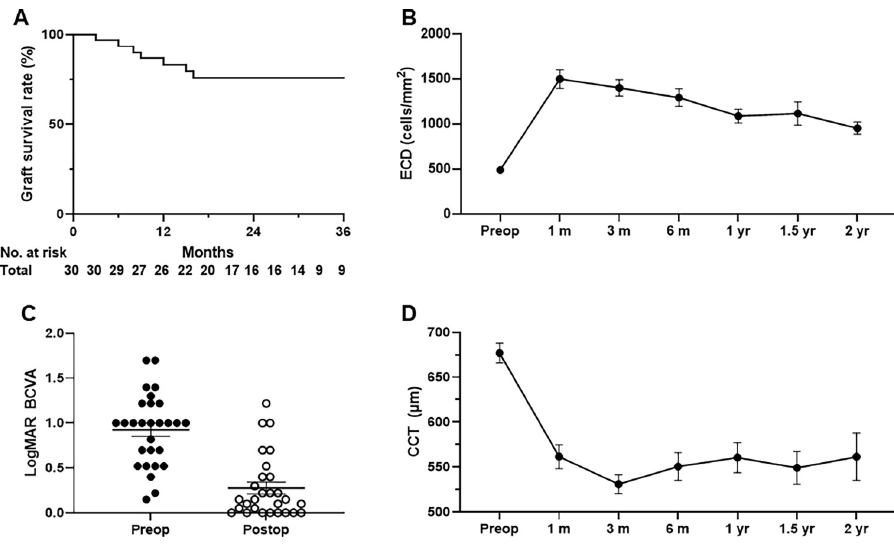
Fig 3. Clinical outcome of Descemet membrane endothelial keratoplasty (DMEK) using overseas transport pre- cut tissues within 3 days. Kaplan-Meier plots of overall imported graft survival rate (A), endothelial cell density (ECD) (B), best corrected visual acuity (BCVA) (C), and central corneal thickness (CCT) (D) in total cases. Data are expressed as the mean ± standard error of the mean (B, C, D).